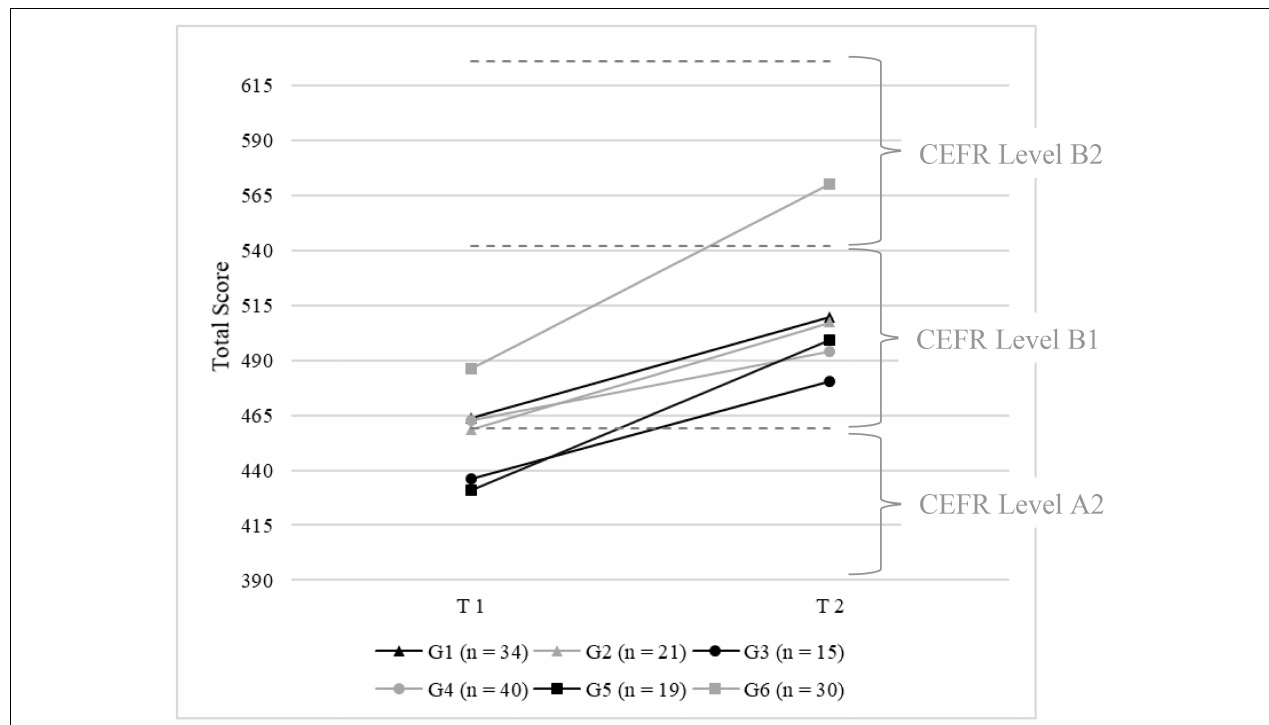
FIGURE 3 | Development of the English skills in terms of the total score (from 310 = worst result to 677 = best result). T, Time of Measurement; G1, student-athletes with Additives Abitur at Elite Sport School 1; G2, student-athletes without Additives Abitur at Elite Sport School 1; G3, student-athletes without Additives Abitur at Elite Sport School 2/3; G4, dropouts at Elite Sport School 1; G5, dropouts at Elite Sport School 2/3; G6, non-student-athletes at comprehensive schools; CEFR, Common European Framework of References for